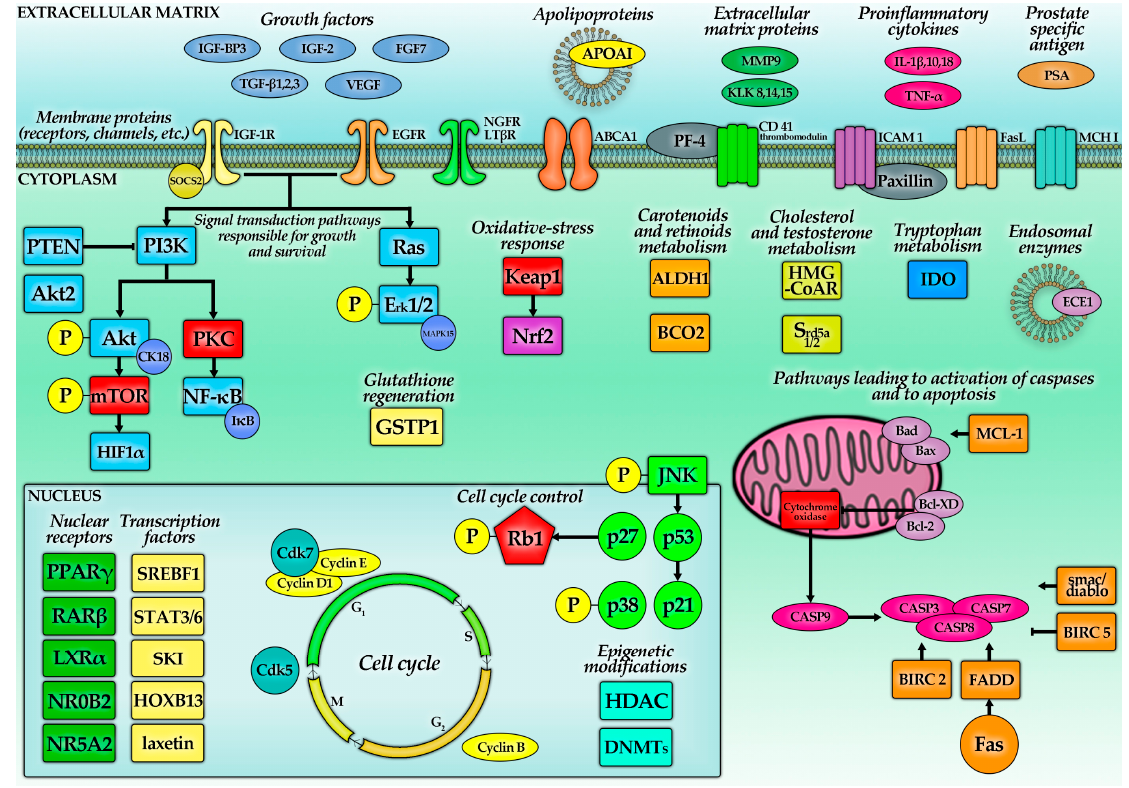
Figure 2. The molecular pathways of carotenoid action in PC (discussed in Section 5), which have been the subject of research in the last decade. They involve the growth factor receptors (i.e., epidermal growth factor receptor (EGFR) and insulin-like growth factor receptor (IGFR)), ABC transporters, molecules of intracellular adhesion (i.e., ICAM-1). Moreover, a variety of proteins, which control the cell cycle and process of apoptosis, change their level under the influence of carotenoids. Significant changes were discovered, as well in the components of extracellular matrix (i.e., matrix metalloproteases (MMPs) and kallikreins (KLKs)). More detailed information of given carotenoids on the particular factors from this figure is shown in Table 4 (the factors marked with red color are not directly reviewed in our work; however they are necessary to understand their relation to well-established functions, e.g.,